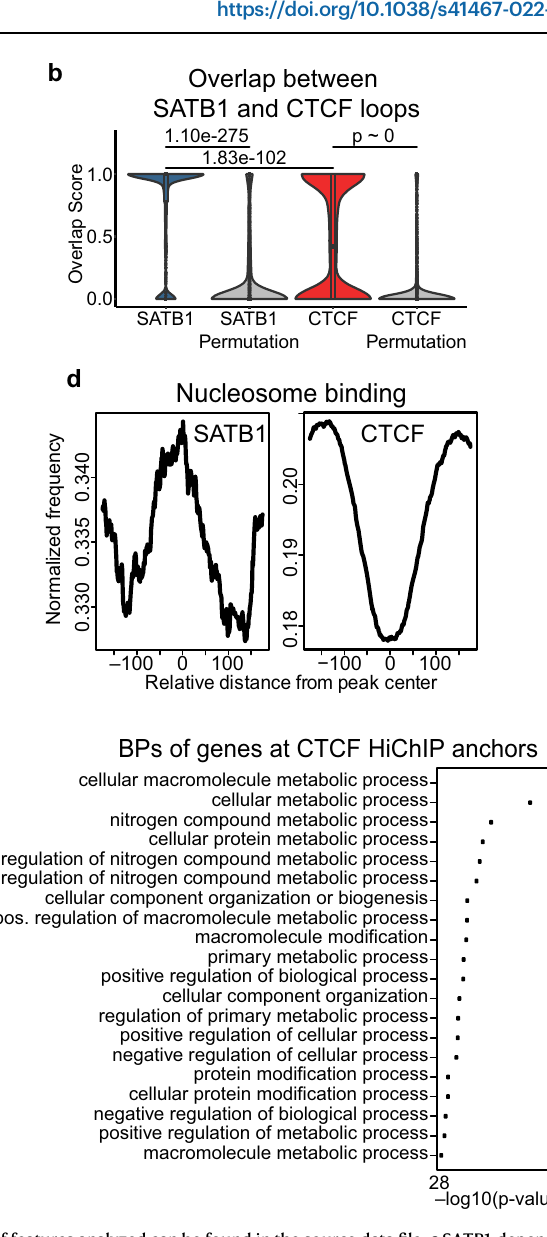
Fig.3|Fine-scaleTcellchromatinorganizationbySATB1.a diffHicanalysis 107 of differentially interacting chromatin areas indicates that CTCF contributes more strongly to the higher order chromatin organization of the murine T cell genome thanSATB1. b OverlapscorebetweenSATB1andCTCFloopscalculatedas(number ofoverlappingbp)/(bpsizeofaloop).Forexample,fortheSATB1-labeledviolin,a score of 1.0 indicates either 100% overlap or engulfment of a SATB1-dependent loop in a loop dependent on CTCF. A score of 0.0 indicates no overlap. The plot indicates that the majority of the SATB1 loops were engulfed in CTCF loops. The same approach was repeated for randomly shuf fl ed loops. P values by